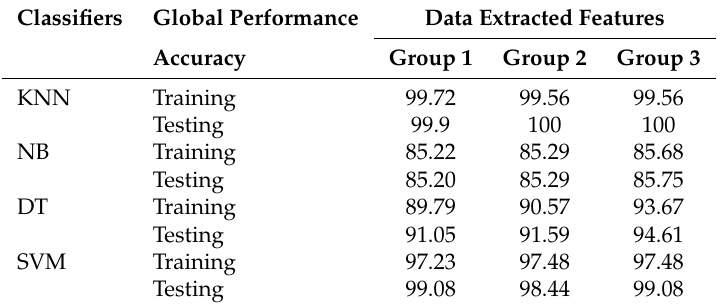
Table 10. Accuracies of extracted features based MSPCA with different